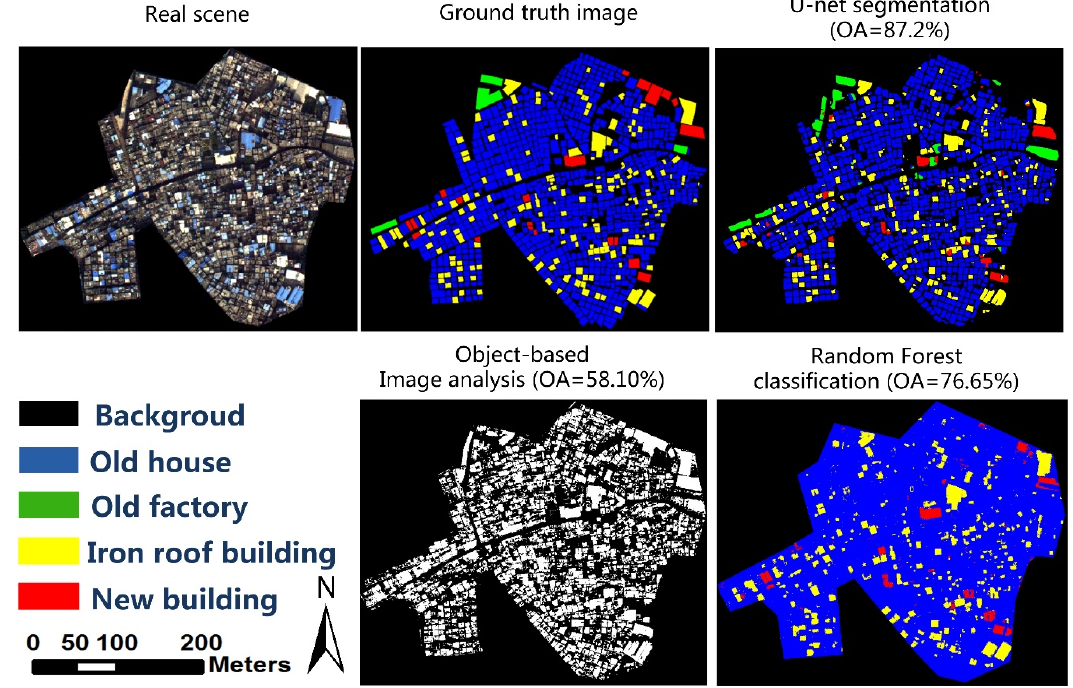
Figure 7. Comparison of the building extraction among the U-net, object-based image analysis, and Random Forest.